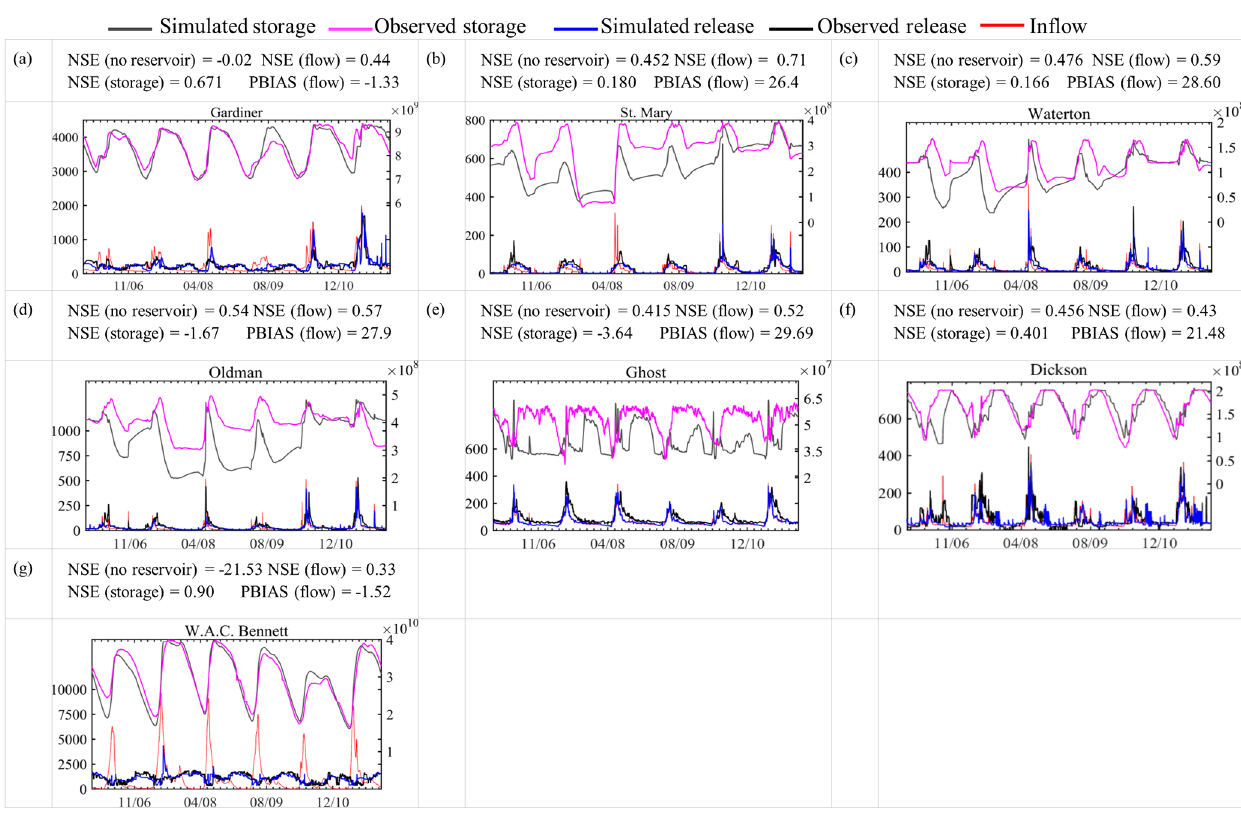
Figure 15. Reservoir simulation results within MESH model run for selected reservoirs; x axis shows time (d), the primary y axes show release (m 3 s − 1 ), and the secondary y axes show storage (m 3